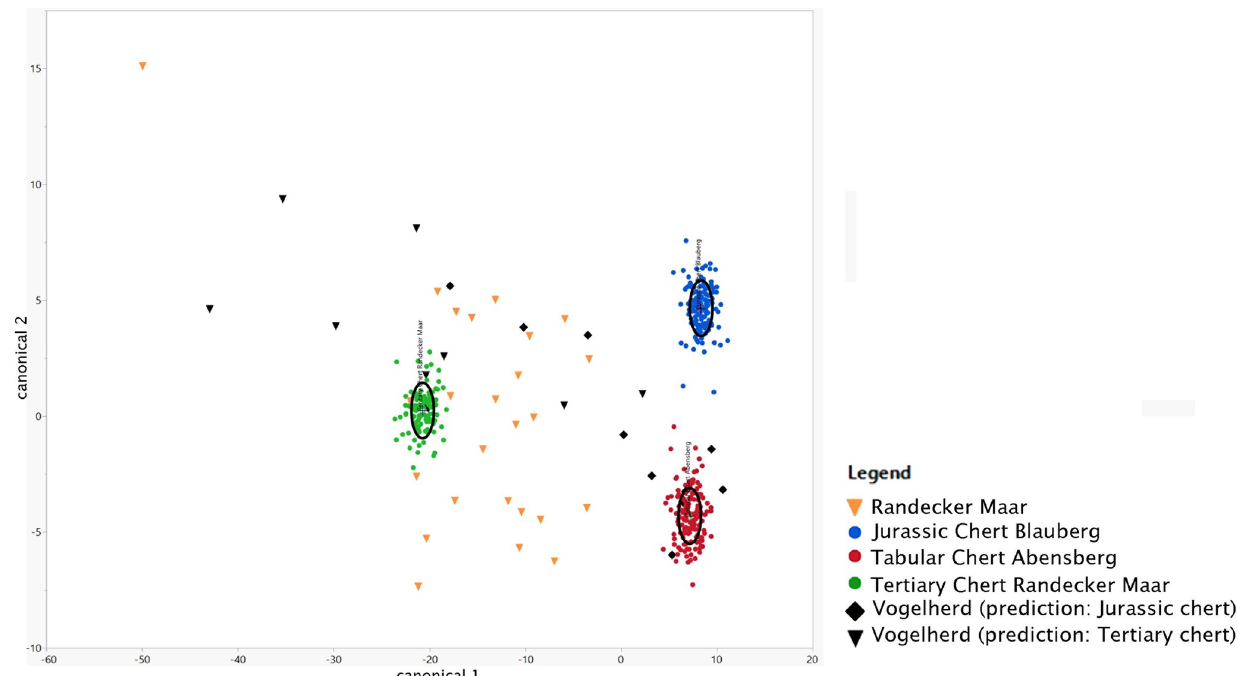
Fig 6. Canonical plot of the LDA. The three groups are coloured in green, blue and red. Archaeological samples are black and orange and were not predefined to a group. The black ellipses encompass 50% of the samples of each group.